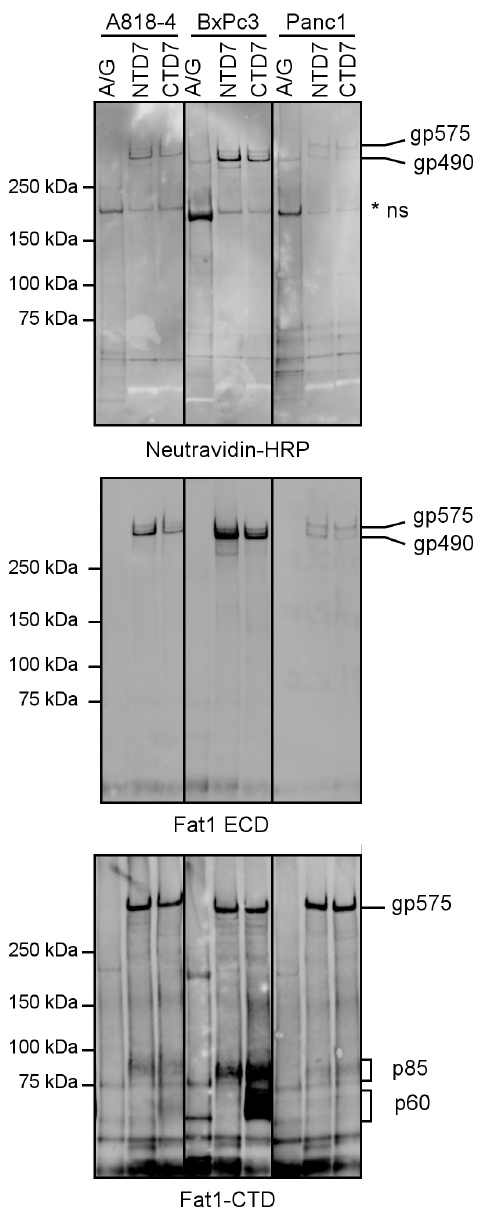
Figure 4. Immunoprecipitation followed by Western blotting indicates two different C-terminal remnant fragments. Cells (Panc1, BxPC3 and A818-4) were labeled with biotin, lysed and precipitated with Fat1 specific monoclonal antibodies (NTD7 and CTD7); protein A/G beads were used as a control. The first incubation of the blot with Neutravidin-HRP indicated bands with high molecular weight corresponding to the known high Mr forms of Fat1 and a presumably crossreactive protein at < 200 kDa. Subsequent Western blotting with the extracellular domain specific antiserum again detects the two high Mr forms of Fat1. Finally, Western blotting with the intracellular domain specific antiserum detects the full-length protein and the p85 C-terminal remnant fragment derived from classical processing in both Fat1 precipitates, confirming the association of the N-terminal and C-terminal parts. An additional p60 is exclusively detected in the precipitate using the intracellular domain-specific antibody with strong signals in BcPC3 and week signals in A818-4 lysates. Immunoprecipitation (IP) analysis of Fat1 after cell surface labeling of Panc1, BxPC3 and A818-4 cells with biotin. IPs using domain specific mAbs against Fat1 along with a control (protein A/G